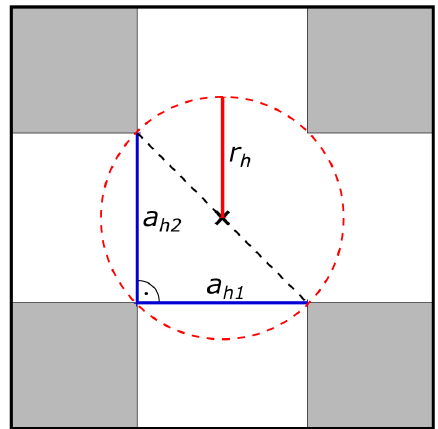
Figure 2. 2D sketch of the half-hypotenuse assumption in an ideal- ized rectangular fracture crossing (gray regions indicate rock ma- trix, white regions fracture pore space). The hydraulic apertures ( a h1 and a h2 ) of both intersecting fractures are indicated with solid blue lines. The hypotenuse of the right-angled triangle with the two hydraulic apertures as legs is given by the black dashed line. The hydraulic radius r h (indicated by the solid red line) to approximate the radius of the pipe model is defined as half the length of the hy-